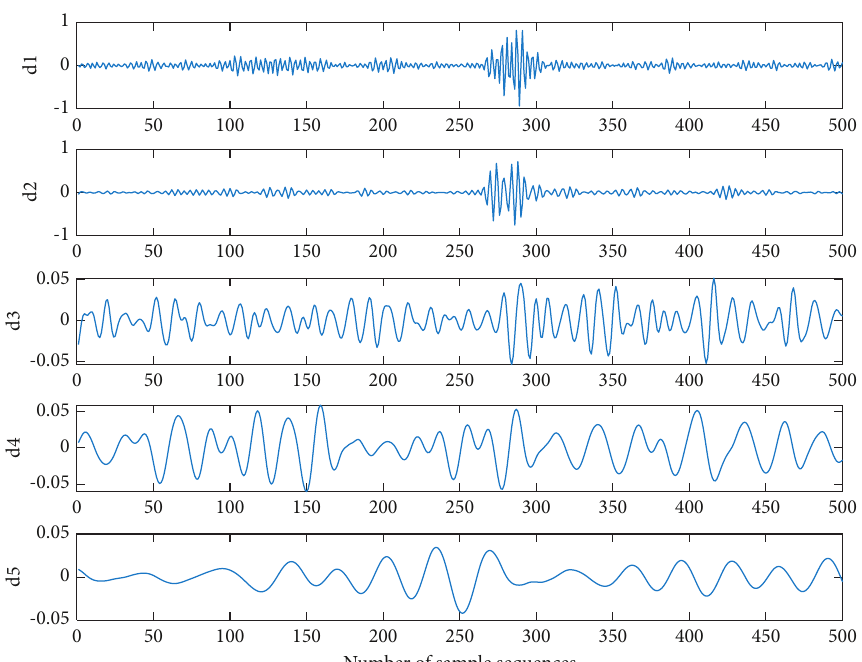
Figure 9: Wavelet decomposition chart of 0.5334mm inner race